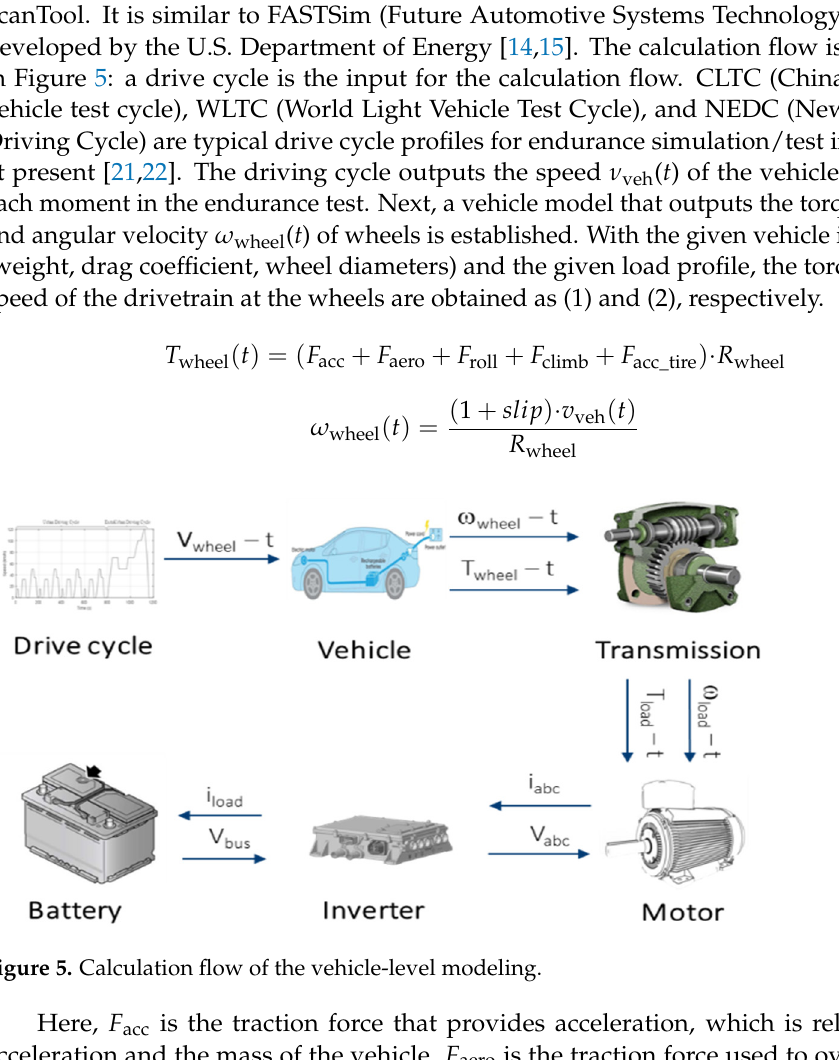
Figure 6. Profile of CLTC-P drive cycle.